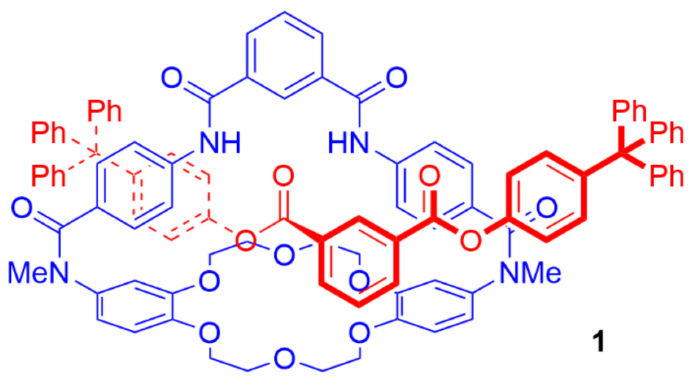
Figure 1. Structure of Smith’s original rotaxane 1 containing a heteroditopic isophthalamide/crown ether macrobicycle in the absence of coordinating ions.